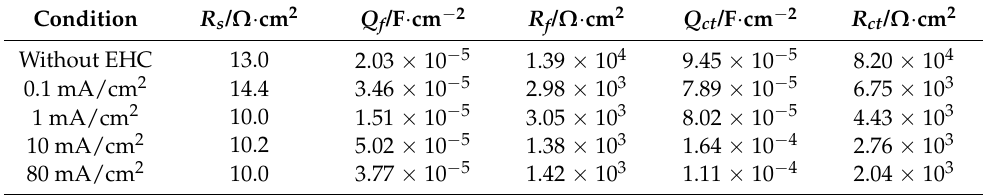
Figure 5. Equivalent circuits used for modelling the EIS results. Table 3. Impedance parameters under different hydrogen charging current densities.